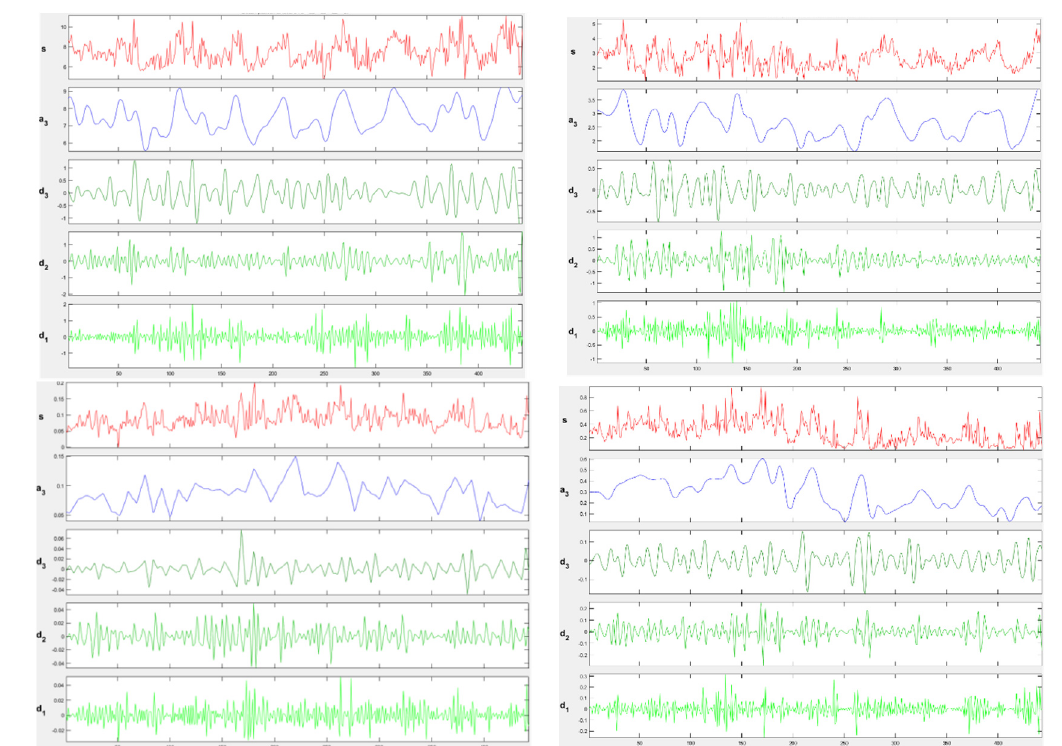
Figure 8. Original images and three-layer decomposition images of DO, CODMn, TP, and NH 3 -N datasets.